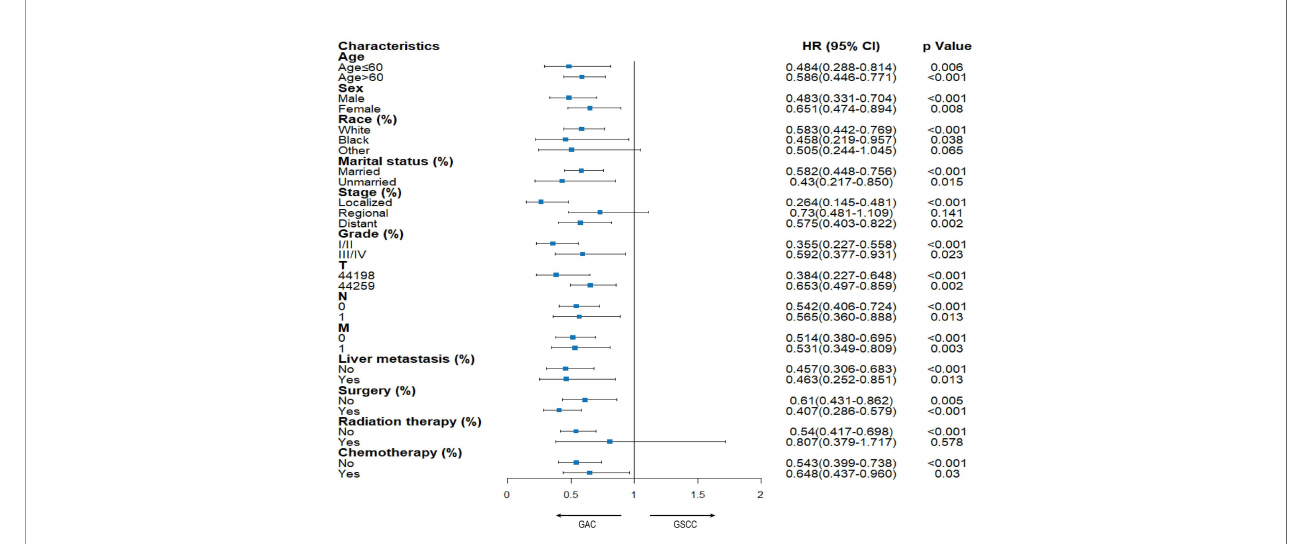
FIGURE 4 | Strati fi ed analysis between GAC and GSCC